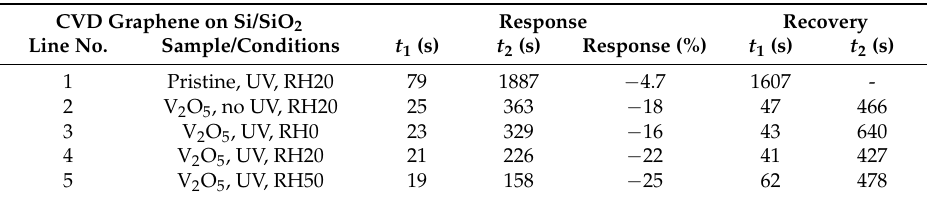
Table 1. Bi-exponential fitting parameters of functionalised CVD graphene sensor response and recovery curves at 8 ppm NH 3 , as shown in Figures 4 and 5, with Equation (1). The coefficients t 1 and t 2 are time constants in the exponential functions. Response amplitude ( A 1 + A 2 )/ G 0 is shown in %. RH stands for relative humidity.